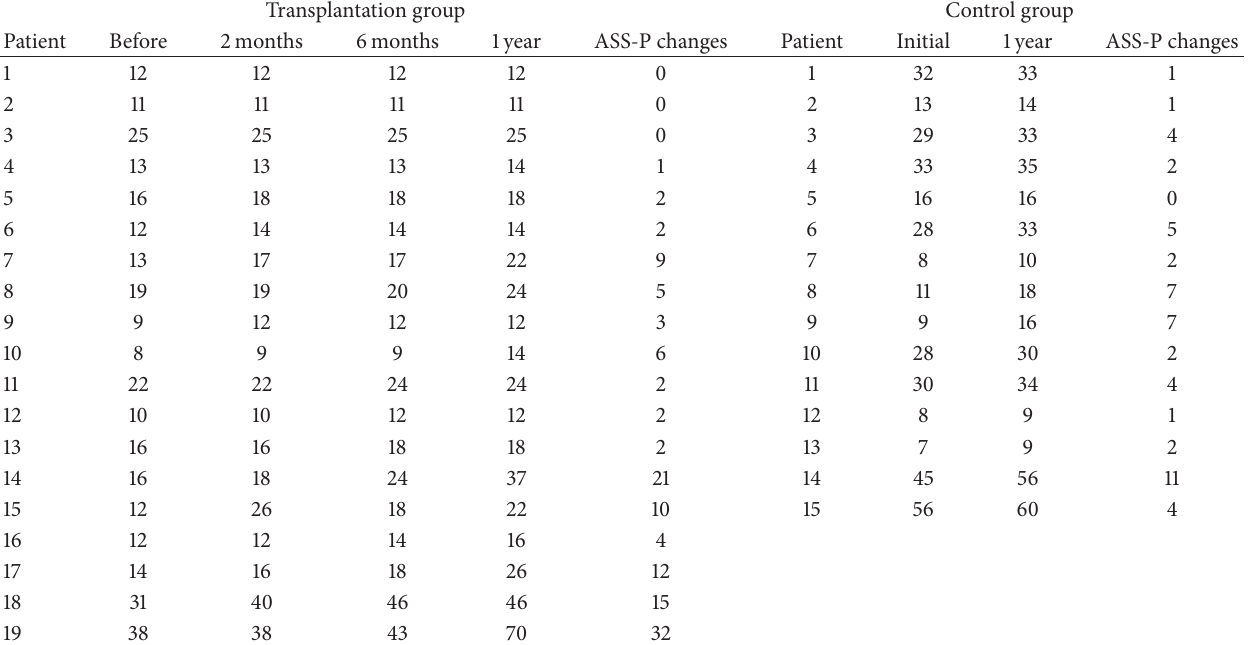
Table 8: ASS-pin prick